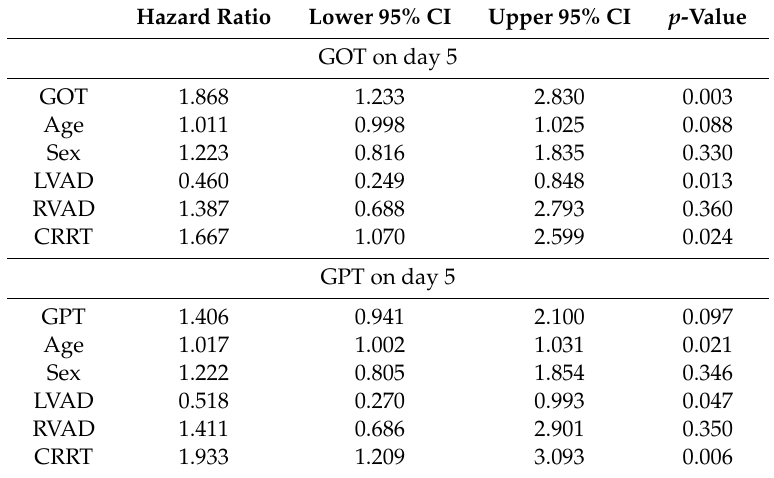
Figure 4. Cox proportional hazards model for investigating the association between the survival time of patients undergoing ECLS therapy with the exclusion of shock liver patients and bilirubin levels on day 5 if bilirubin was >2.23 mg/dL (red line) or <2.23 mg/dL (blue line) (cutoff- alue as determined by the Youden index), including a predefined multivariable adjustment. Table 3. Multivariate analysis for glutamic-oxaloacetic transaminase (GOT) and glutamic-pyruvic-transaminase (GPT).